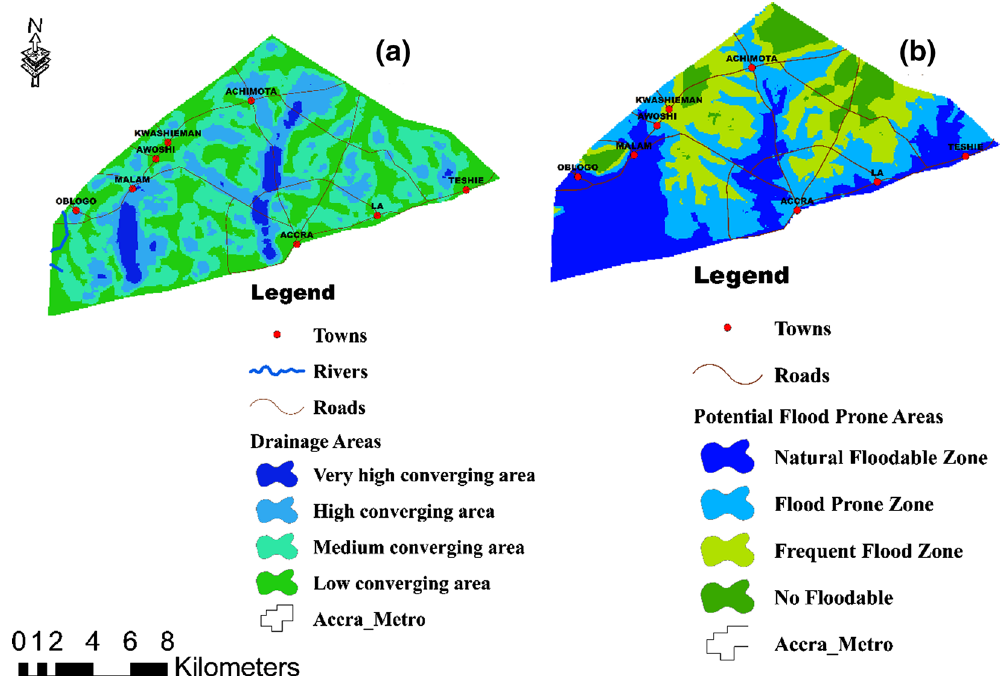
Fig. 3 a Drainage density map and b map of floodable areas